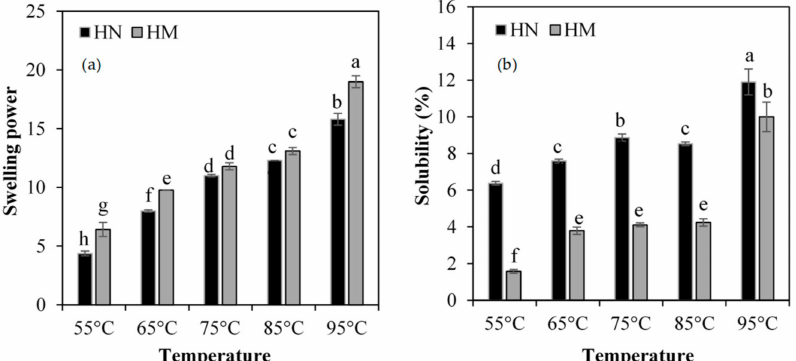
Figure 4. Swelling power ( a ) and solubility ( b ) of Hom Nil rice flour (HN) and Hom Mali 105 rice flour (HM). The results are expressed as mean ± SEM, n = 5. The different letters denote statistically significant differences in mean values. ( p < 0.01) Mean values with the same superscript letters (a, b, c, d or e) were similar and no statistically significant differences were observed for these